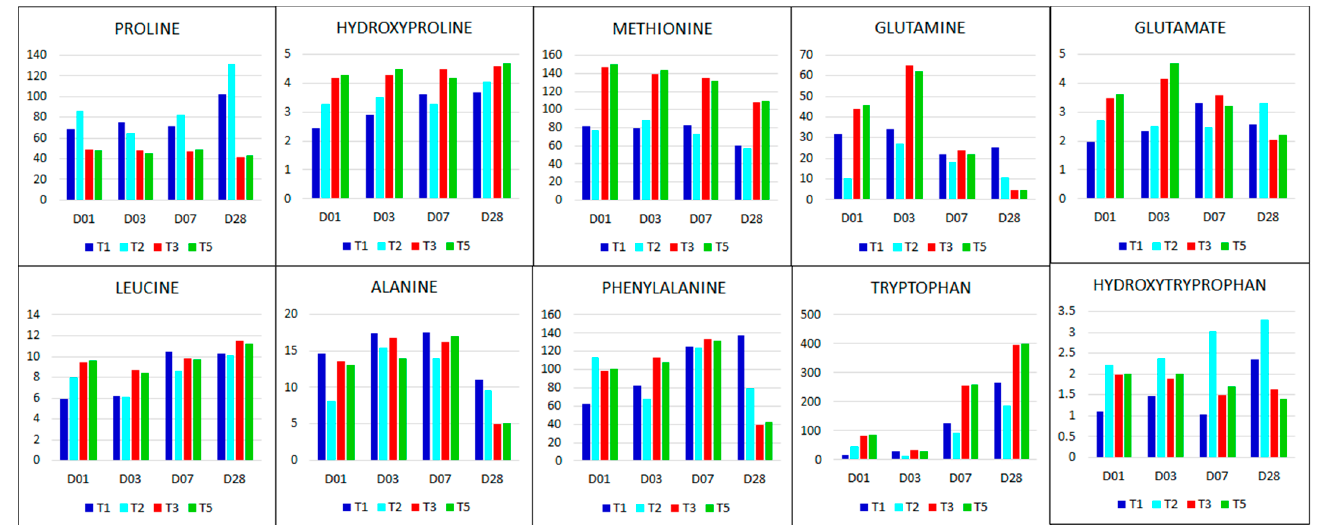
Figure 6. Differential changes in amino acid levels across all treatments at all time points. The column graphs were constructed using integrated peak areas (IPA) of amino acids in non-stress—(T1: dark blue), salt stress—(T2: light blue), and biostimulant-treated salt-stressed (T3: red and T5: green) conditions across all time points (days 1, 3, 7 and 28).